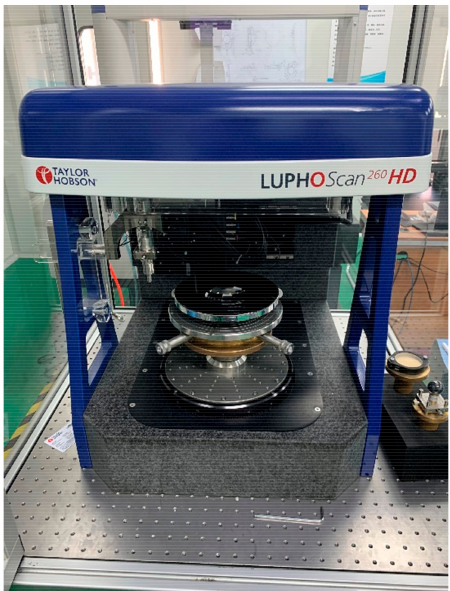
Figure 14. The mirror is testing on